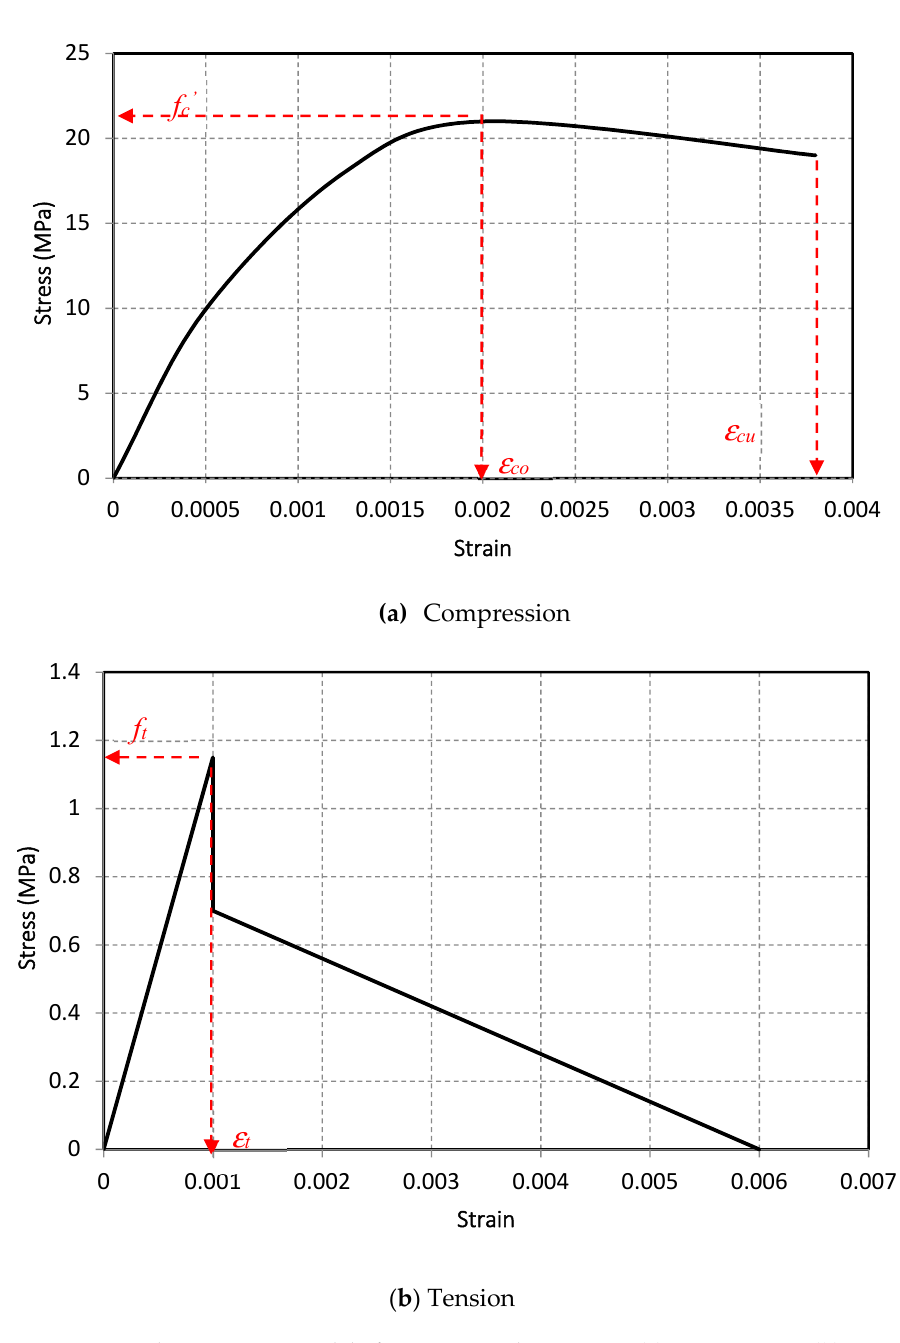
Figure 2. Typical stress-strain model of concrete used in ANSYS: (a) Compression; (b) Tension.